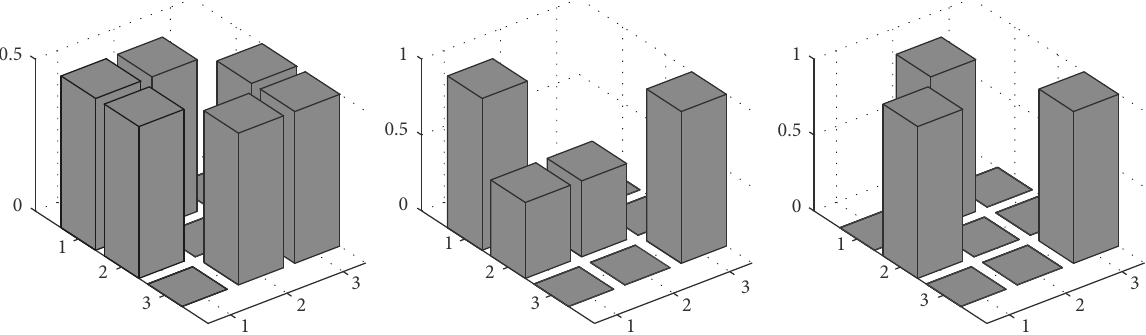
Figure 1: Illustration of various degrees of